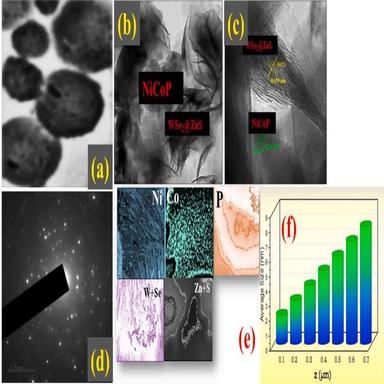
TEM & HRTEM images of NiCoP/WSe2@ZnS (a-c), SAED pattern of NiCoP/WSe2@ZnS (d), the corresponding pattern EDS elemental Mapping (e) and average size of particle (f).